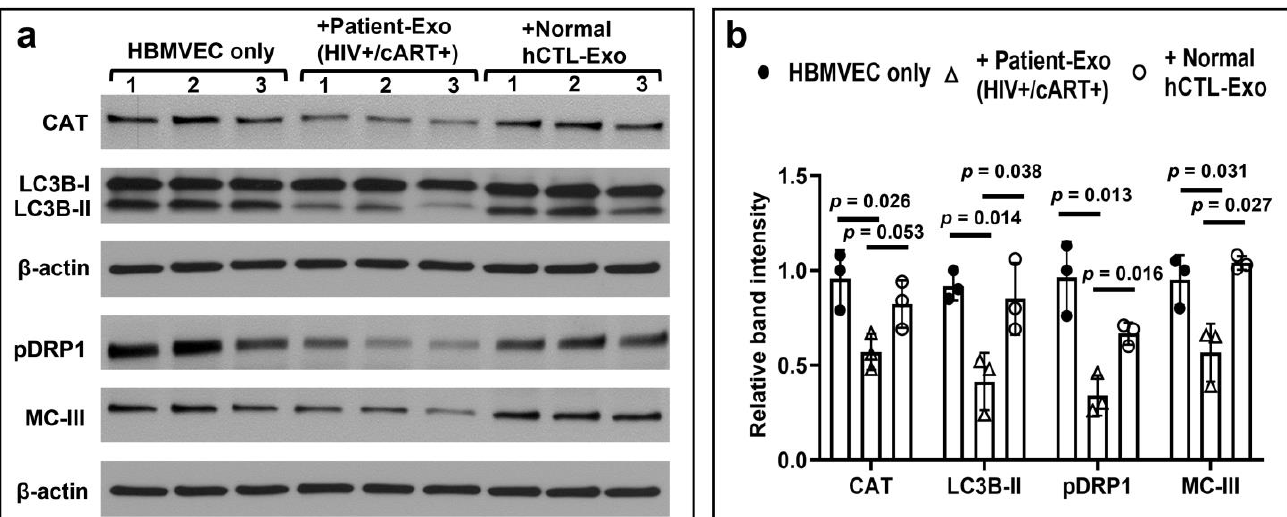
Figure 8. The effect of HIV-infected and cART-treated Patient-Exo on primary HBMVECs. ( a ) Cells were treated with 10 µg/mL of both Patient-Exo as well as exosomes isolated from healthy human plasma (hCTL-Exo) for 24 h. The indicated proteins were qualitatively detected by Western blotting from equal amount (15 µg) of clarified cell lysates and β-actin was used as an internal control. Three independent experiments were performed and are presented by Arabic numbers. ( b ) The relative band intensities of CAT, LC3B-II, pDRP1, and MC-III were compared by Image-J software (version 1.50). Values were mean ± standard deviation (SD). The data set passed the Shapiro–Wilk normality test and unpaired t test with Welch correction was performed for normally distributed data. q-values: all of them are 0.041 for HBMVEC only vs Patient-Exo; and 0.054, 0.043, 0.041, 0.041 for hCTL-Exo vs. Patient-Exo.